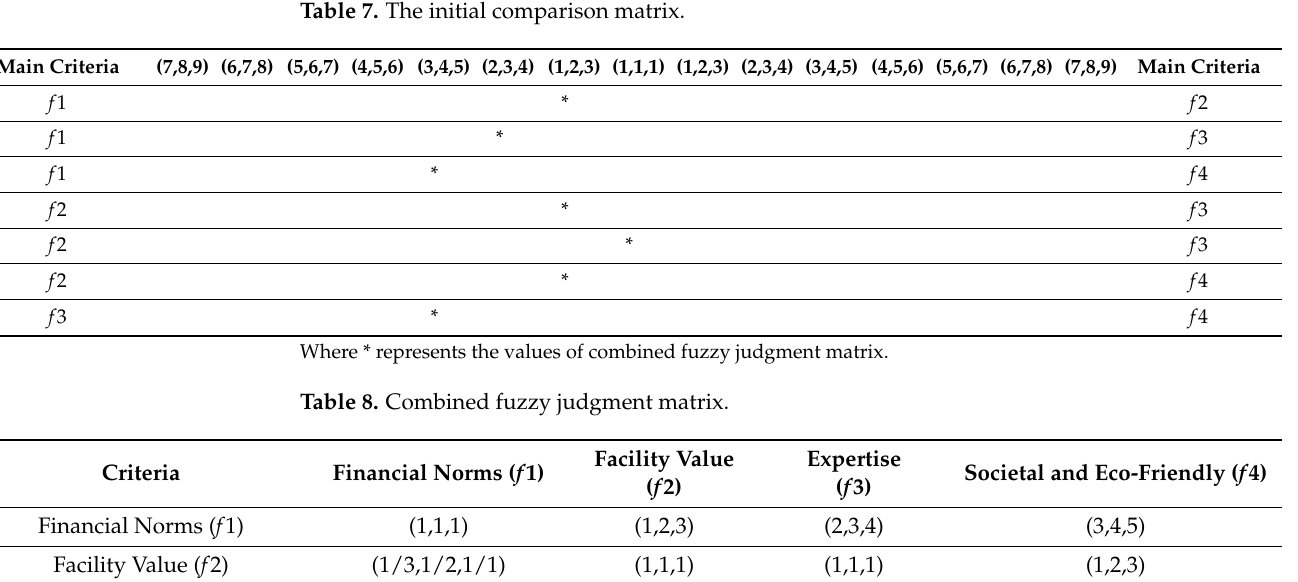
Table 7. The initial comparison matrix.